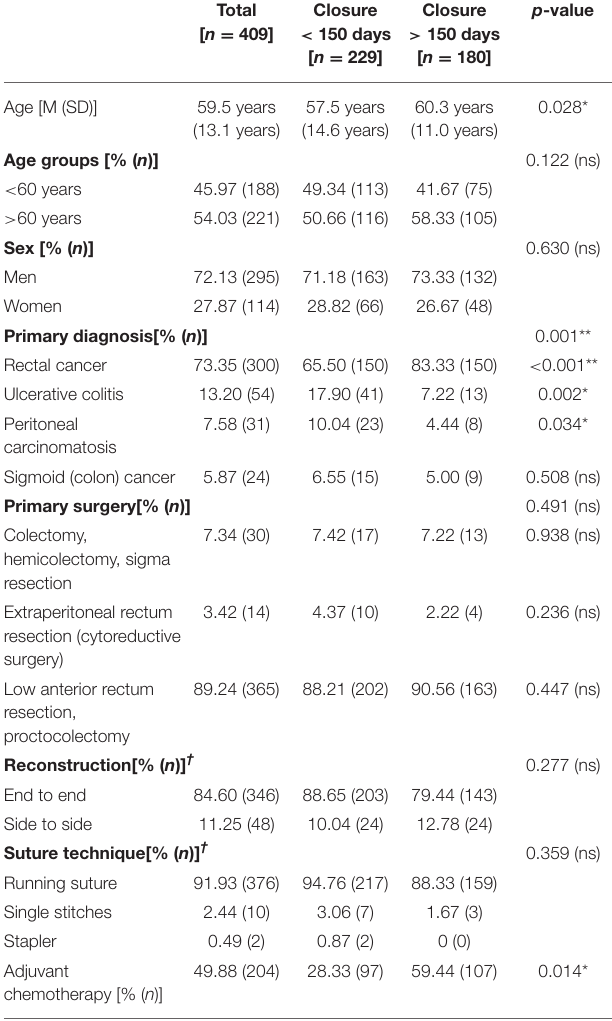
TABLE 2 | Distribution of risk factors in the overall population and within the subgroups of early and late